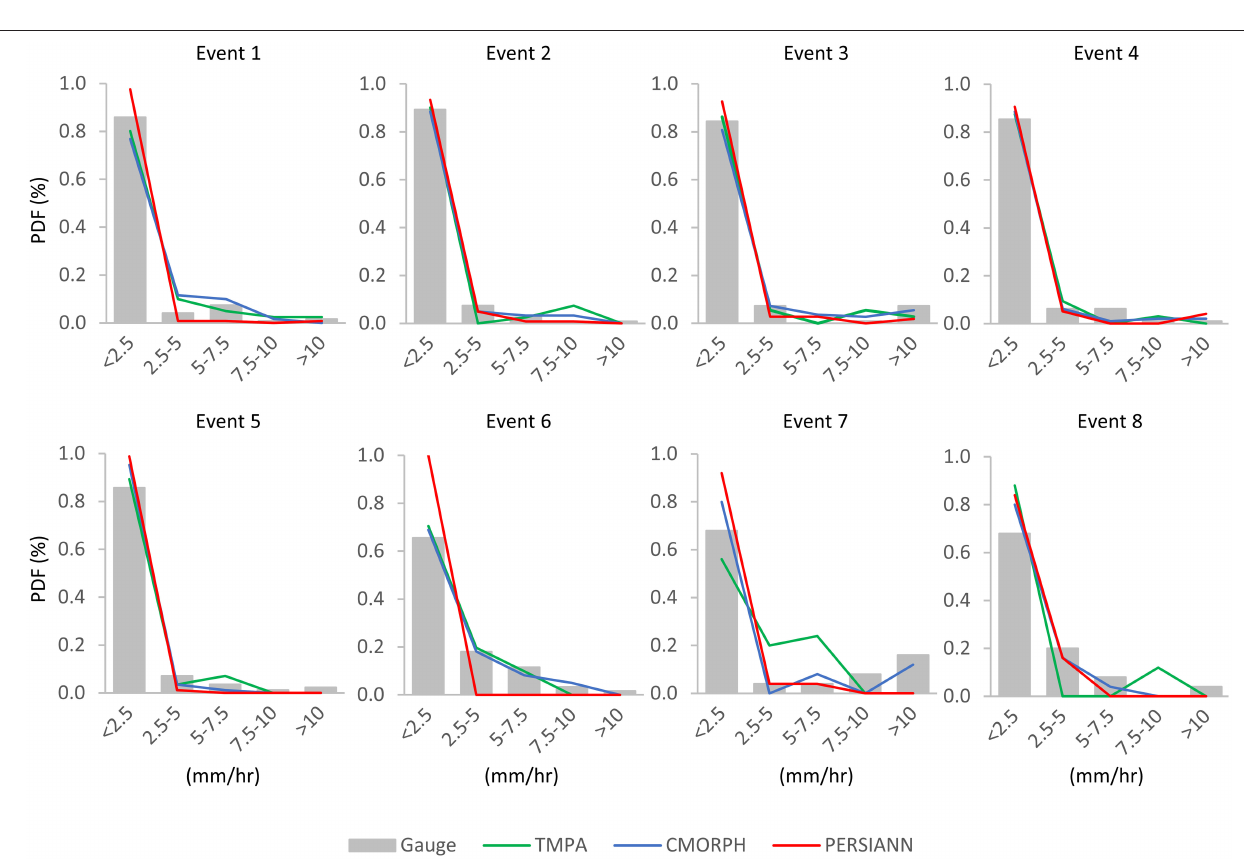
Frontiers in Environmental Science |